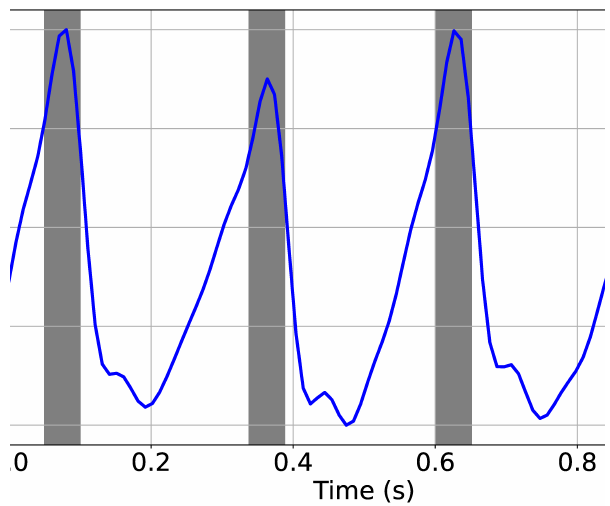
Figure 10. Tolerance distance (50 ms) is shaded in the figure. If the peak is detected within this range it is considered as true